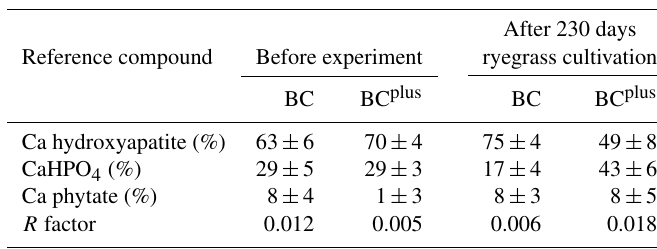
Table 3. Results of linear combination fitting (LCF) conducted on P K -edge XANES spectra of bone char (BC) and surface-modified bone char (BC plus ) particles before and after 230 days of ryegrass cultivation in a pot experiment. These best fits were achieved using all possible combinations with 19 spectra of P reference